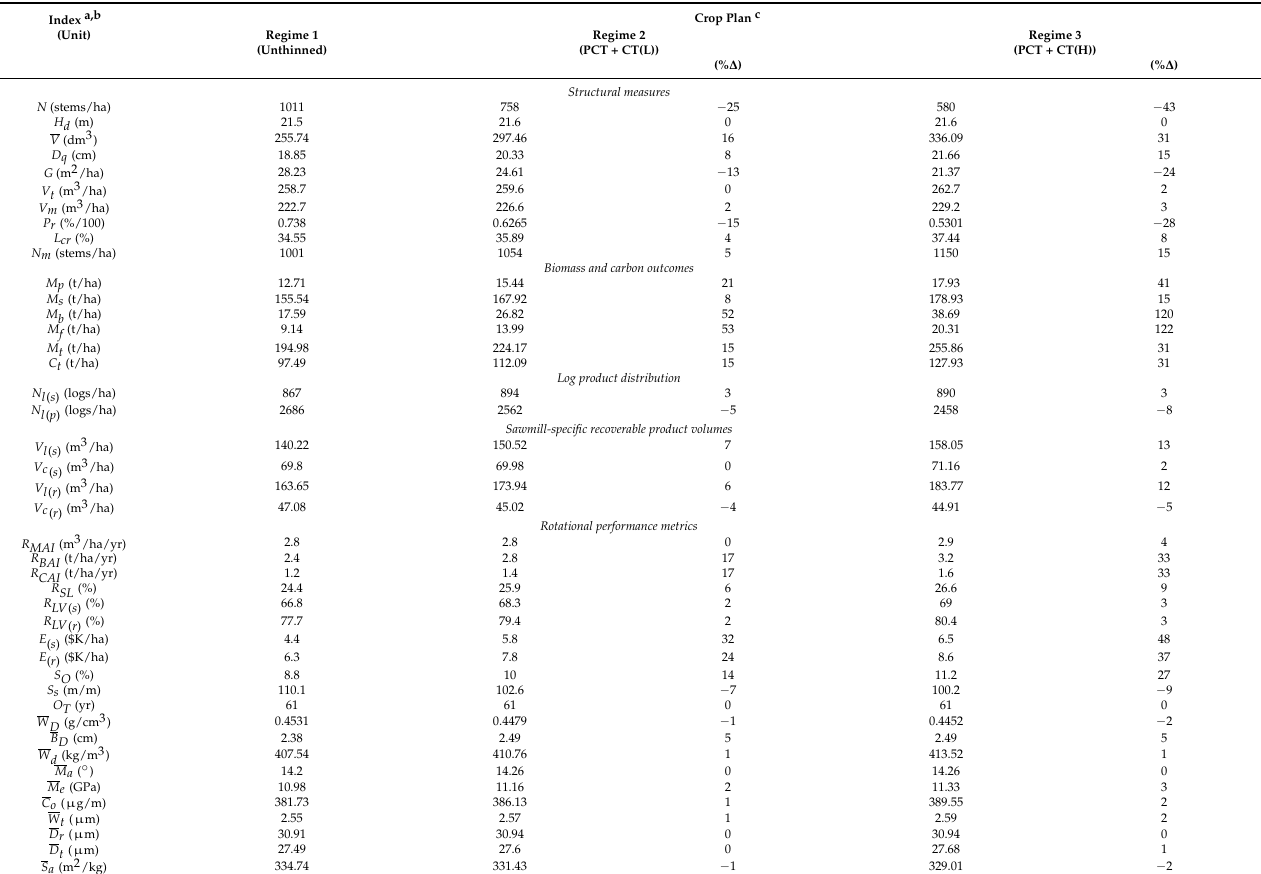
Table 2. Crop-plan-specific rotational (80 yr) outcomes: stand structure attributes, volumetric yields, log assortments, biomass and carbon outcomes, product volumes, end-product-related wood quality metrics, and productivity and economic indices, for natural-origin jack pine stands established at high initial densities (3500 stems/ha) growing on medium-to-good quality sites (site index of 18 [65]) which were left unthinned (Regime 1) or subjected to density control treatments (PCT of 750 stems/ha at 15 yr and a CT of 15% basal area removal at 65 yr (Regime 2); and PCT of 750 stems/ha at 15 yr followed by a CT of 30% basal area removal at 65 yr (Regime